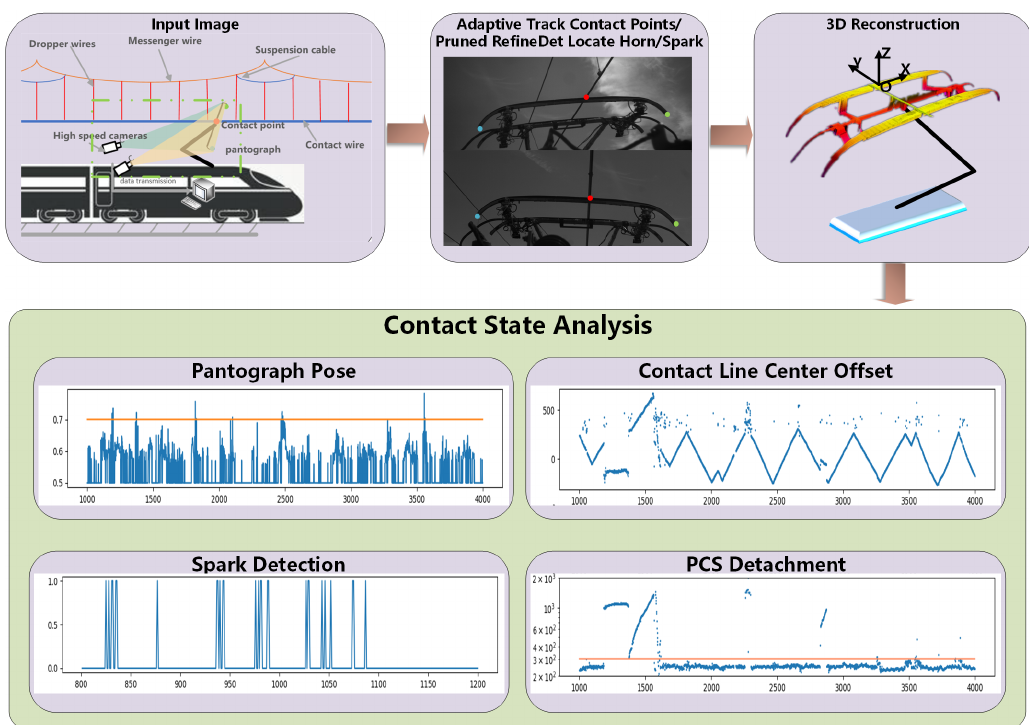
Figure 1. Overview of the online pantograph and catenary system (PCS) intelligent perception analysis system and illustra- tion of the four modules: data collection, feature localization, reconstruction, and data